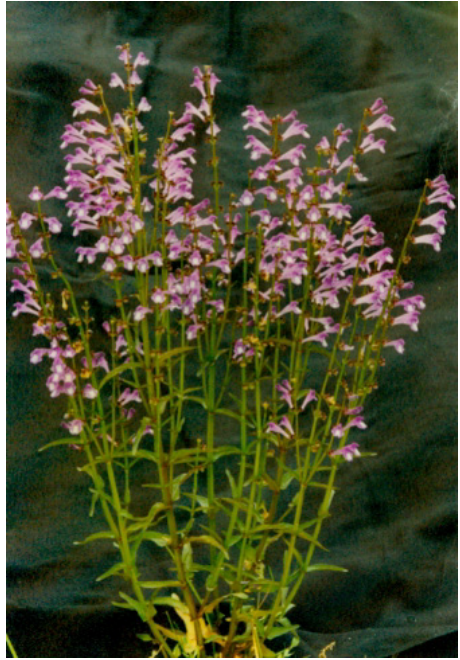
Figure 1. Photograph of Scutellaria barbata D.